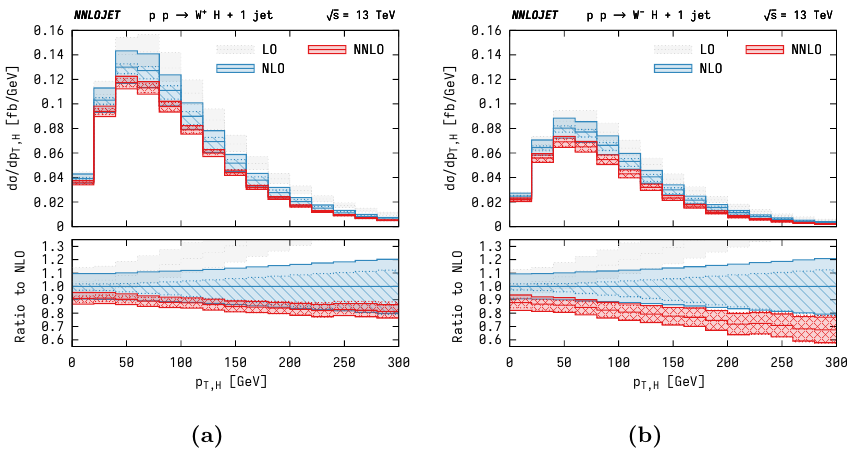
Figure 5. The transverse momentum distribution of the Higgs boson produced in exclusive WH + jet production for (a) W + (b) W −